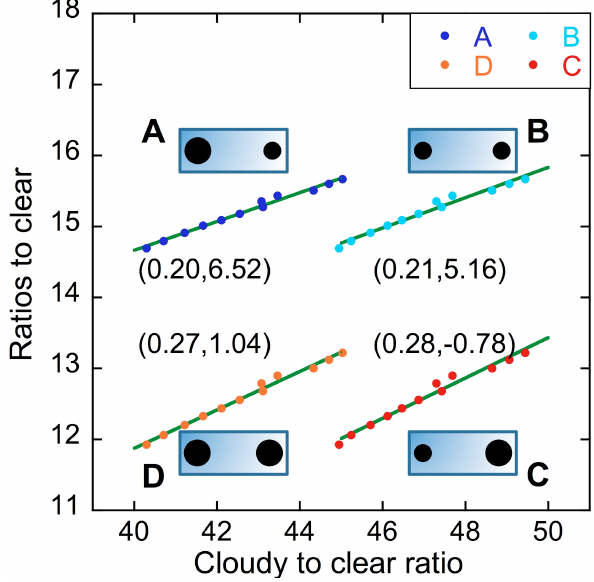
Fig. 6. Spectrally-invariant relationships derived from band B5 (2110–2220nm) for situation A–D. Numbers in parentheses are the slope and intercept of the linear relationship (green lines) at τ c = 0 . 5. Each box next to letter A–D schematically illustrates the change of cloud drop effective size in the transition zone. In each box, the filled black circle on the left represents the cloud drop size at τ c = 3 . 0 (the fully cloudy area), while the circle on the right rep- resents the drop size at τ c = 0 . 5 (toward the fully clear area). The smaller circle represents a cloud drop effective radius of 4µm, the larger circle represents an effective radius of 8µm. Based on these rules, in situation B, cloud drop sizes remain a constant of 4µm. In situation D, cloud drop sizes remain a constant of 8µm. In situation A, cloud drop sizes decrease from 8µm at τ c = 3 . 0 to 4µm toward clearly regions. On the contrary, in situation C, cloud drop sizes increase from 4 to 8µm toward clear regions.